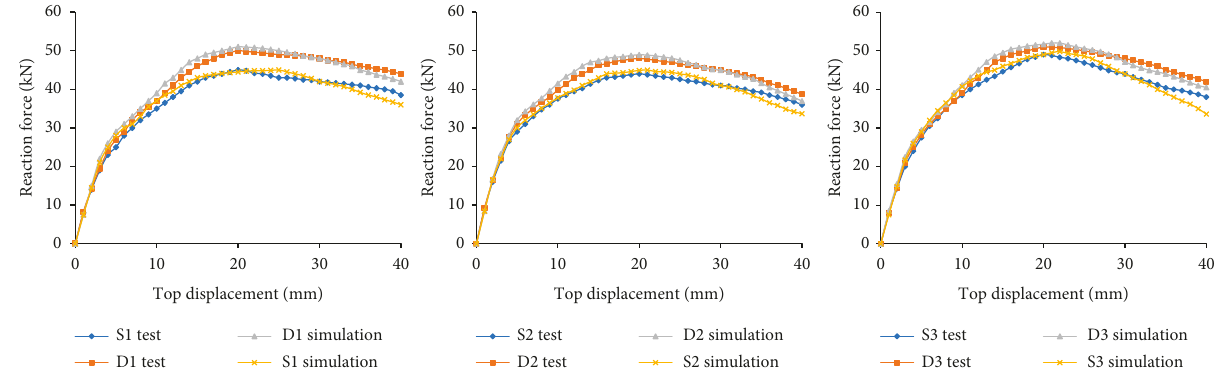
Figure 6: Comparison of simulated and test results.